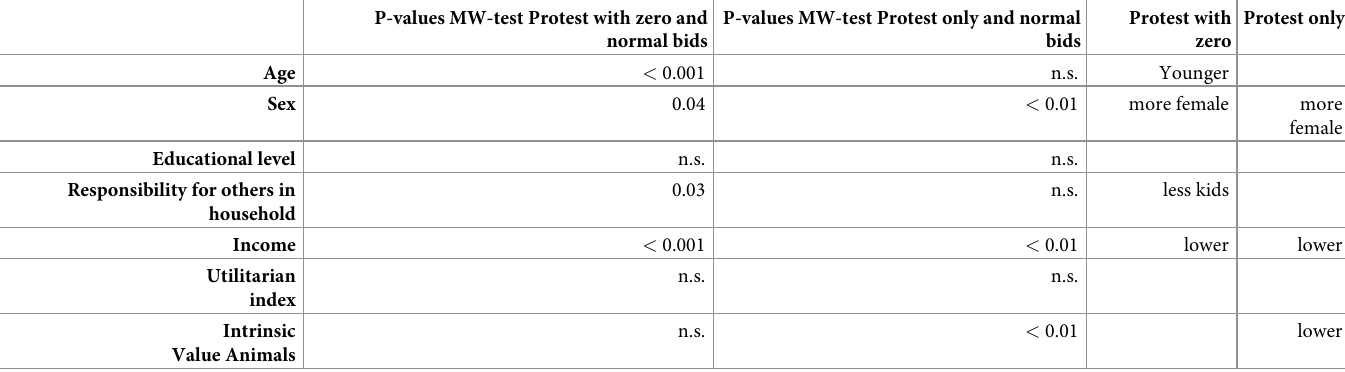
Table 3. Demographics of protest groups compared to the rest of the sample (n.s. = not significant, if n.s. cells indicating direction are left